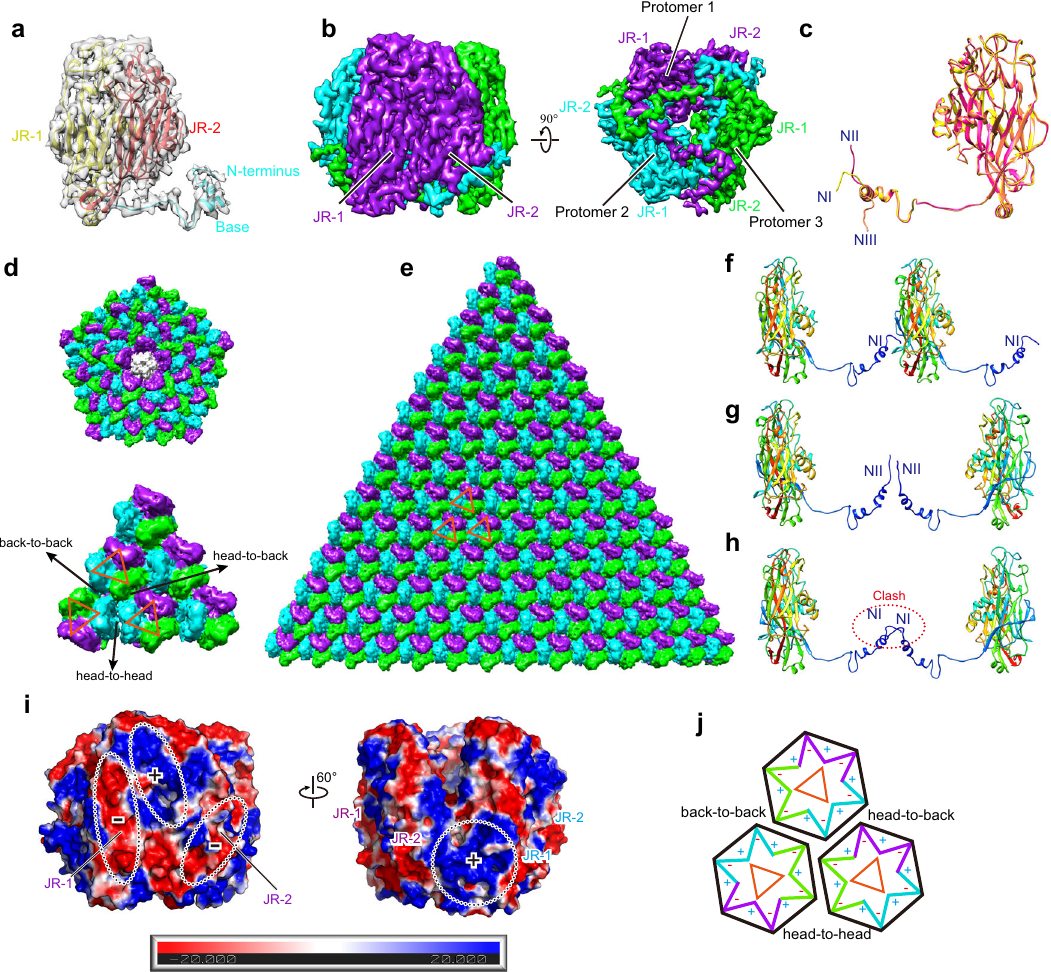
Fig.2|StructureandarrangementoftheSGIVMCP.a Atomicmodelanddensity map of one VP72 monomer. The double JR domains (JR-1 and JR-2) are colored in yellow and red, respectively. Additionally, the N-terminal base is colored in cyan, and the C-terminus is colored in orange. b Cryo-EM map of one trimeric VP72 capsomer, three protomers of which are colored in purple, cyan, and green. Six JR domainswithinonetrimerformtheverticesofapseudo-hexamer.EachN-terminal base extends along the bottom of the neighboring protomer until the interface formedbyanothertwoprotomers. c ThreeconformationsofN-terminalresiduesof the MCP protomers, labeled NI (yellow), NII (hot pink), and NIII (orange). d , e The arrangementofMCPcapsomersinsymmetrons.ThegrooveformedbyJR-1andJR- 2 in one protomer is shown as the vertex of a triangle (orange) that is used to represent the orientation of the MCP capsomer. Each vertex of the triangle is